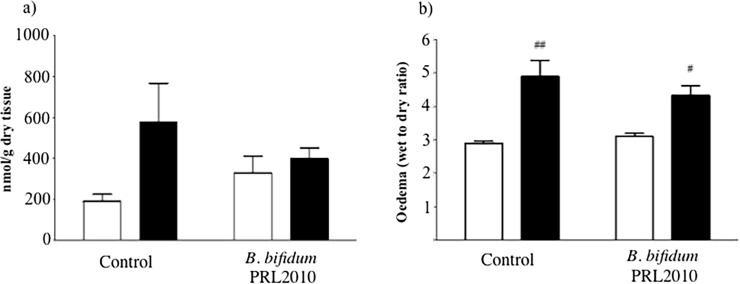
Effects of B. bifidum PRL2010 on oxidative stress and vascular permeability in I/R mice.MDA levels (a) and edema (b), expressed as wet-to-dry weight ratio, in intestinal tissues excised from SO (white columns) and I/R (black columns) mice orally administered with vehicle (Control) or supplemented with B. bifidum PRL2010 (n = 8–10 animals per group). Two-way ANOVA followed by Bonferroni’s post test: #P<0.05; ##P<0.01 vs. corresponding SO mice.